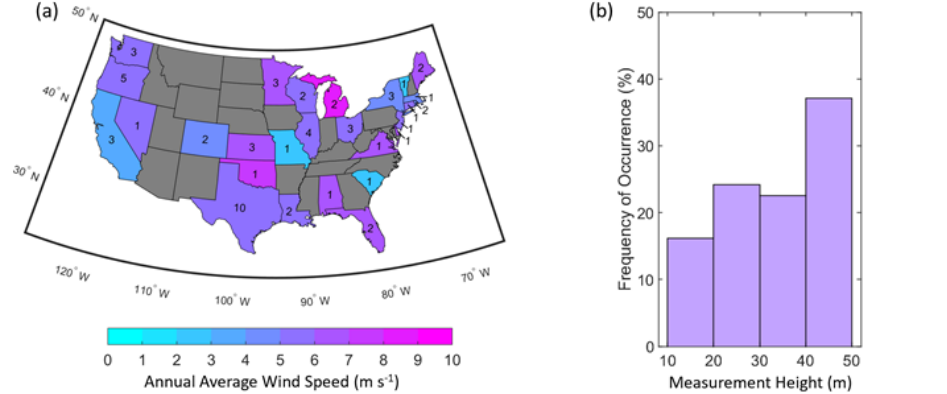
Figure 1. (a) Number of locations and annual average observed wind speeds determined from the measurements made in each state (states with insufficient observations at small wind heights are indicated in grey) and (b) histogram of wind speed observations according to mea- surement